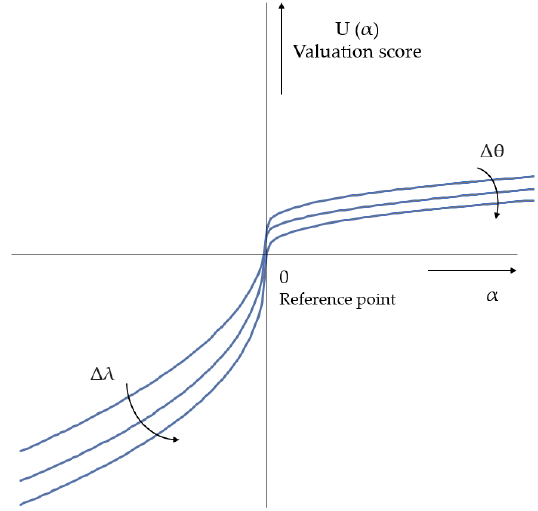
Figure 9. Power utility curves, where θ represents perception of risk and diminishing sensitivity and λ reflects loss aversion.